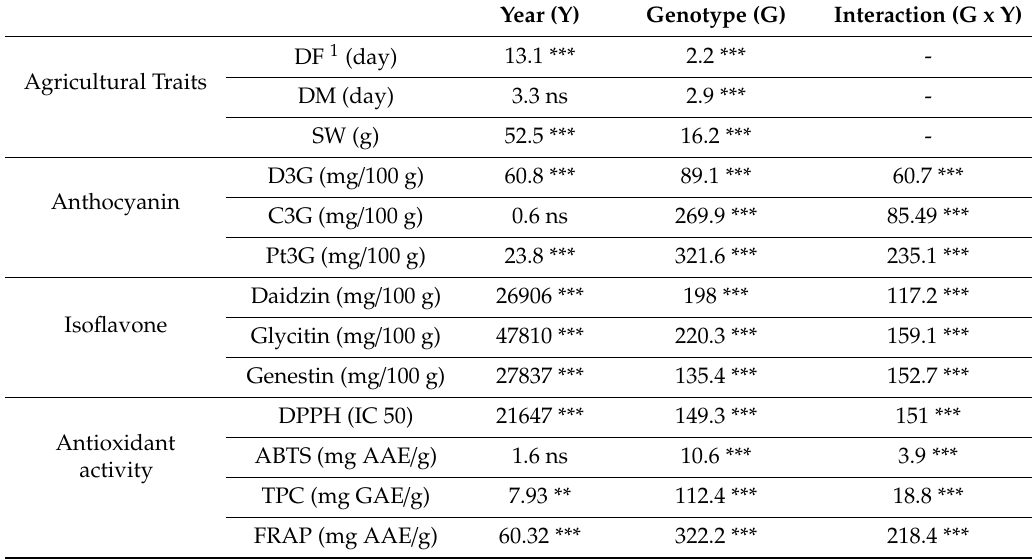
Table 2. Mean squares according to year, genotypes and year x genotype